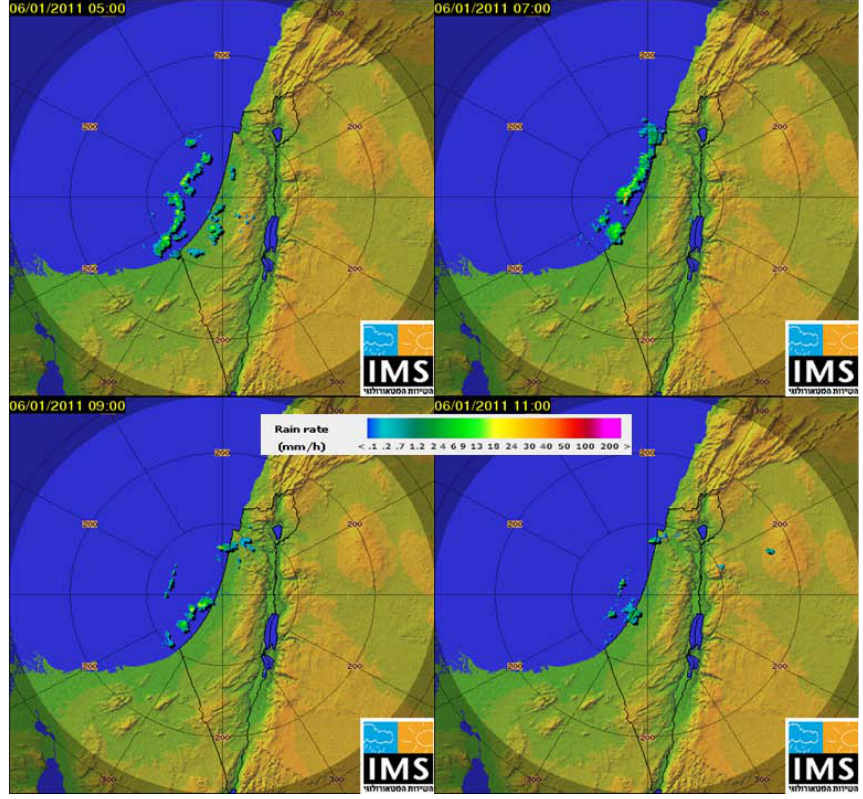
Fig. 1. Radar image evolution of rain clouds off the coast of Israel, 6 January 2011, from 05:00 to 11:00local time, at two hour intervals. The rain clouds started dissipating after sunrise. The image serves as an example of an almost stationary precipitation line formed offshore, and is likely attributed to an offshore LB front. Image taken from the Israeli Meteorological Service (IMS) website, at http://www.ims.gov.il.